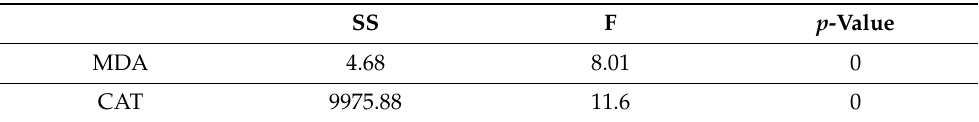
Table 4. Analysis of variance of MDA and CAT for all